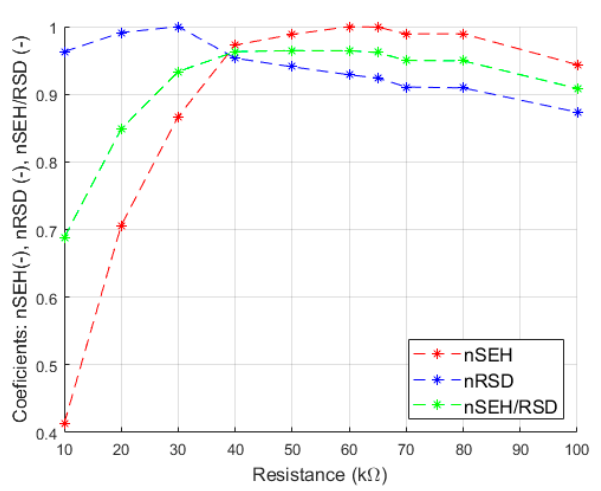
Figure 12. Comparison of energy harvesting and passive vibration damping.